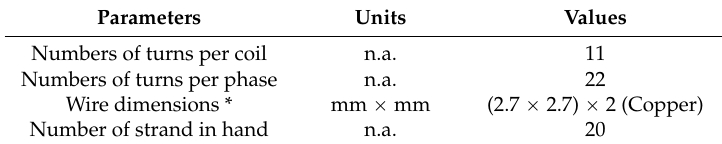
Table 8. Windings.